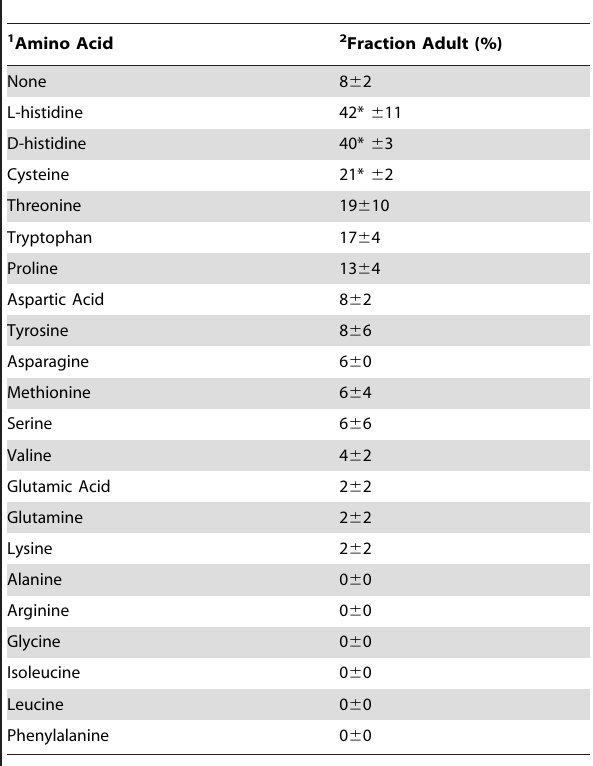
Table 1. Supplementation with amino acids.